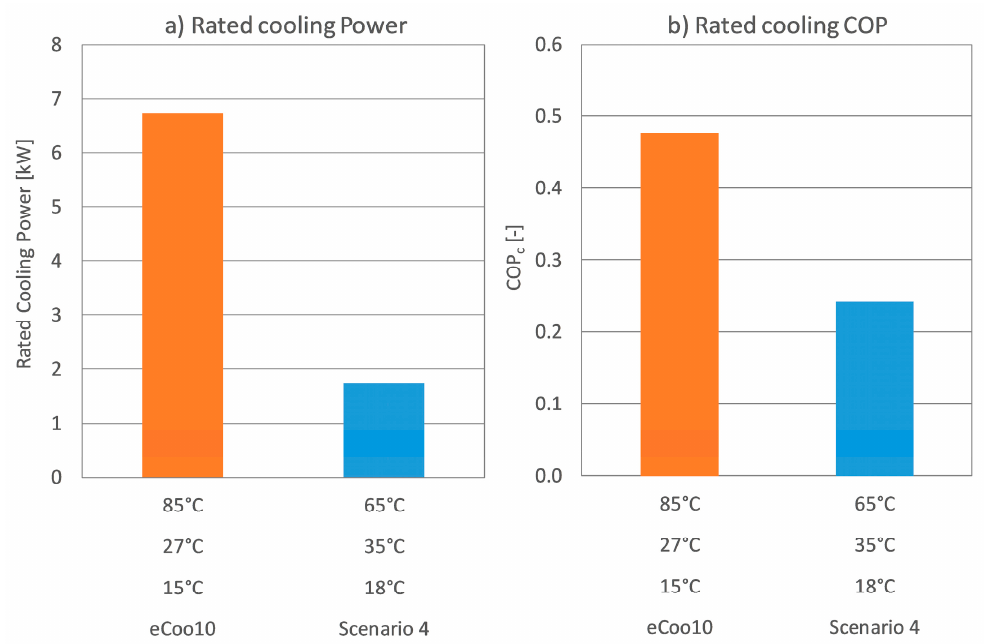
Figure 10. Experimental results at reduced flow rates of the eCoo10 for the heating application scenarios (1–3), ( a ) Rated heating power and ( b ) the rated COP for heating.